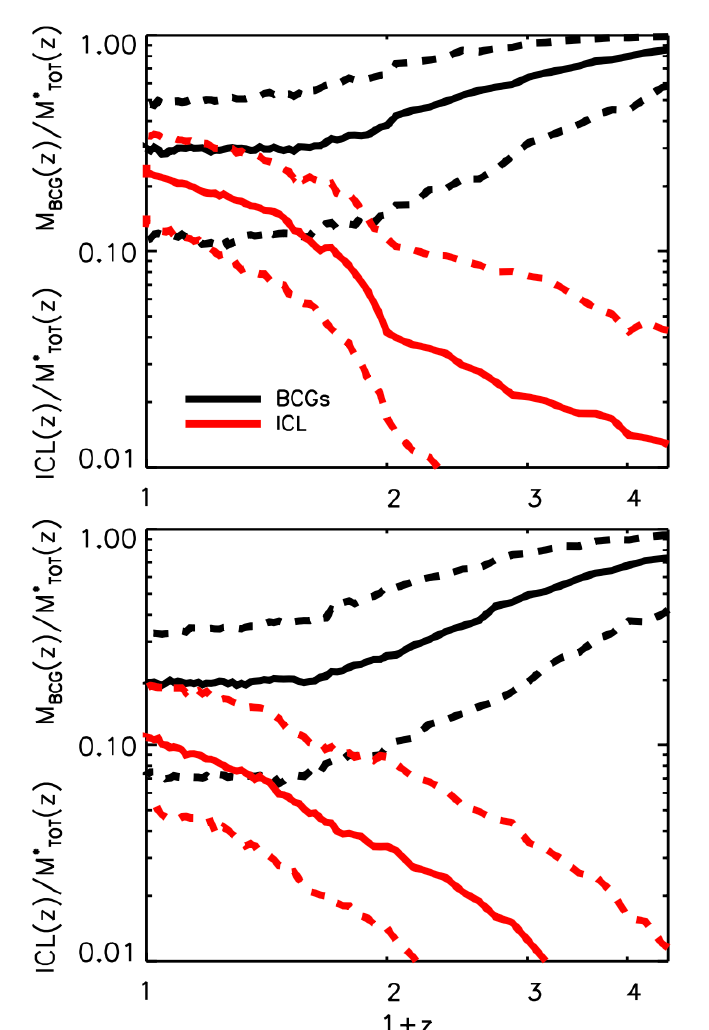
Figure 9. ICL (red lines) and BCG (black lines) fractions as a function of redshift, for a model in which the ICL forms via stellar stripping and mergers (top panel, see description of the model in Section 2.2), and a model where the ICL forms only via mergers (bottom panel). Solid lines represent the median, while dashed lines represent the 14th and 16th percentiles of the distributions. Both fractions have been calculated within R 200 of the halo at any given redshift. Credit: Contini et al.